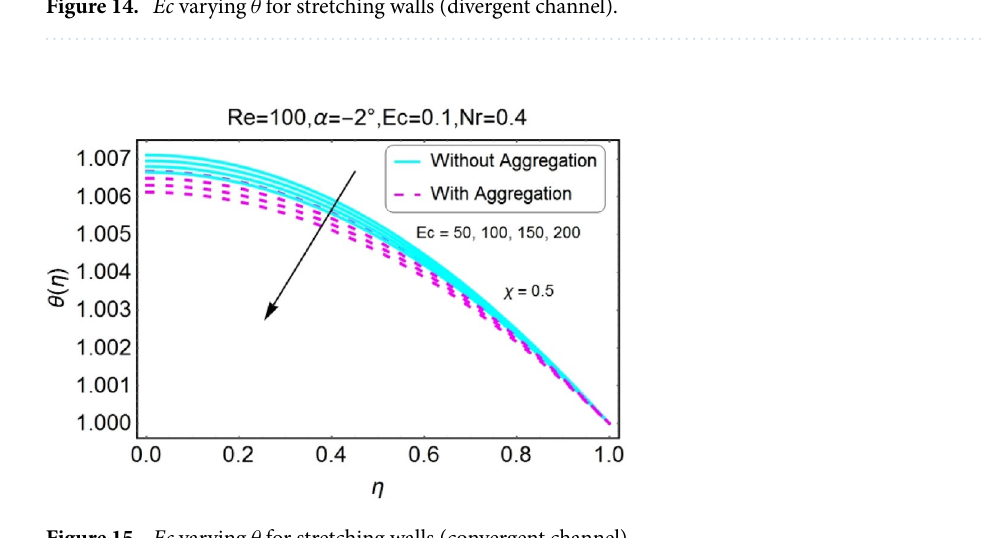
Figure 15. Ec varying θ for stretching walls (convergent